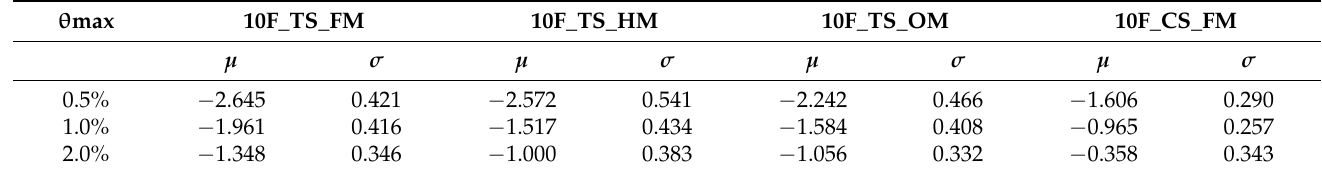
Table 7. Mean ( µ ) and standard deviation ( σ ) values. Table 7. Mean (μ) and standard deviation (σ) values.